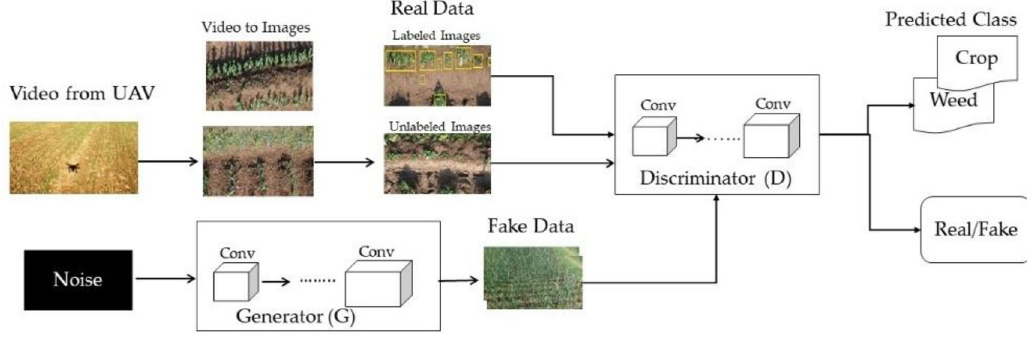
Fig 3. Overview of proposed